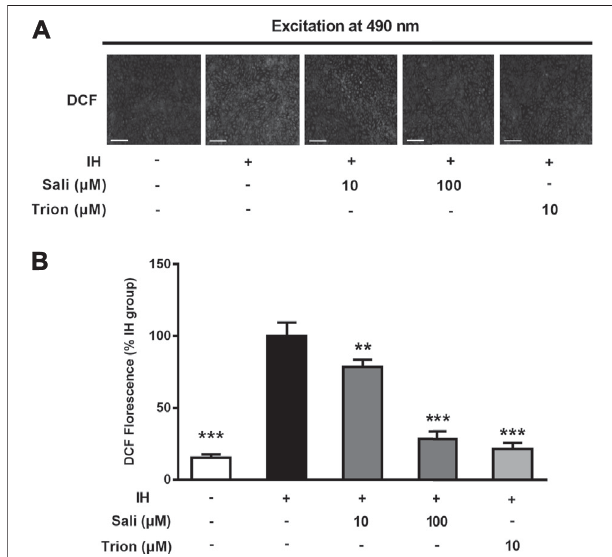
FIGURE 4 | Salidroside attenuated IH-induced ROS overproduction in HUVECs.IntracellularROSlevelsweredeterminedinHUVECspretreatedwith Sali (10 µM or 100 µM) or Tiron (10 µM) for 2 h before exposure to either normoxia or 72 cycles of IH. DCFH-DA was used as a fl uorescent probe for ROS. Tiron was used as a positive control (A) Fluorographs of intracellular ROS were acquired with a fl uorescence microscope (5 × magni fi cation; Bar (cid:1) 500 µm) (B) Fluorescence quanti fi cation results of intracellular ROS. IH, intermittent hypoxia; Sali, salidroside; DCFH-DA, 2 ʹ ,7 ʹ -dichloro fl uorescein diacetate; ROS, reactive oxygen species. All data are presented as mean ± SD. * p < 0.05 and *** p < 0.001 compared with IH